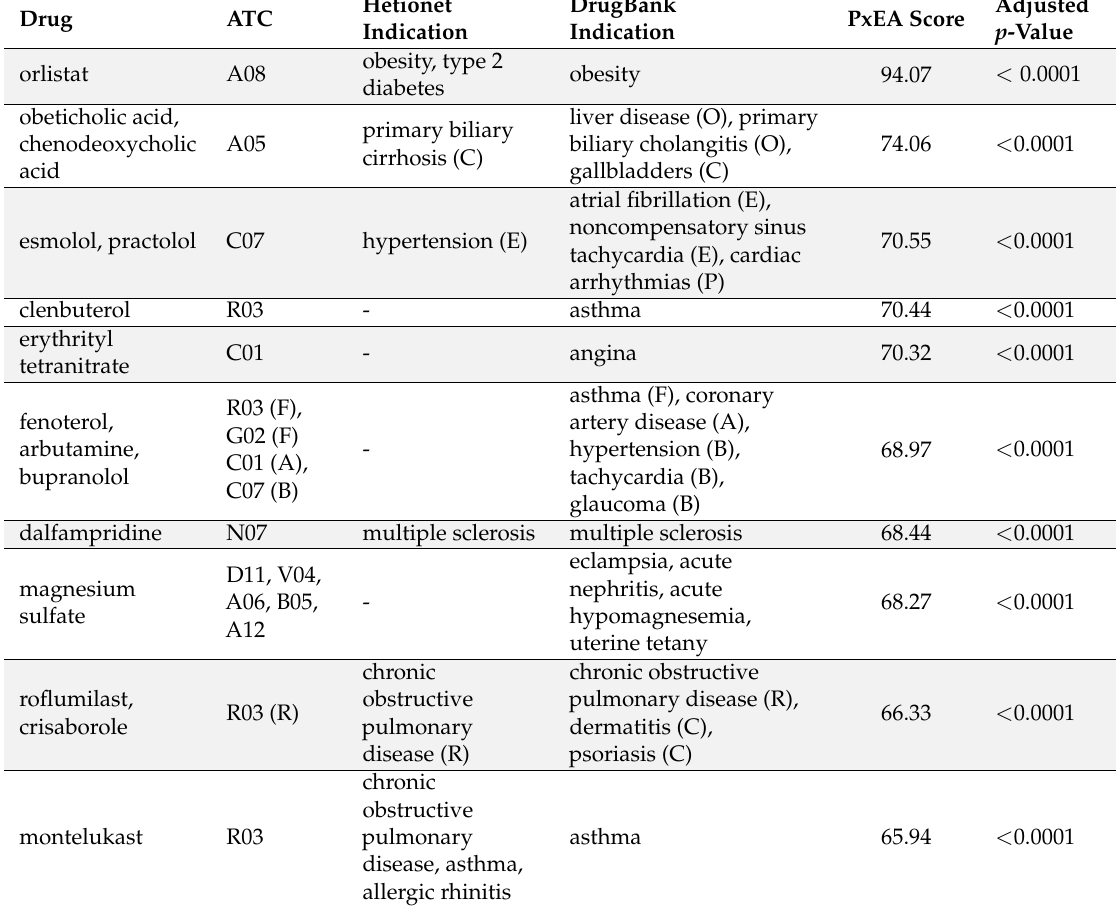
Table 3. Top ten drug repurposing opportunities to target common T2D and AD pathology, where the drugs that target the same proteins according to DrugBank are grouped together in the same row and the Anatomical Therapeutic Chemical (ATC) classification and indication information within the same group is marked with the first letter of the drug in the parenthesis (if